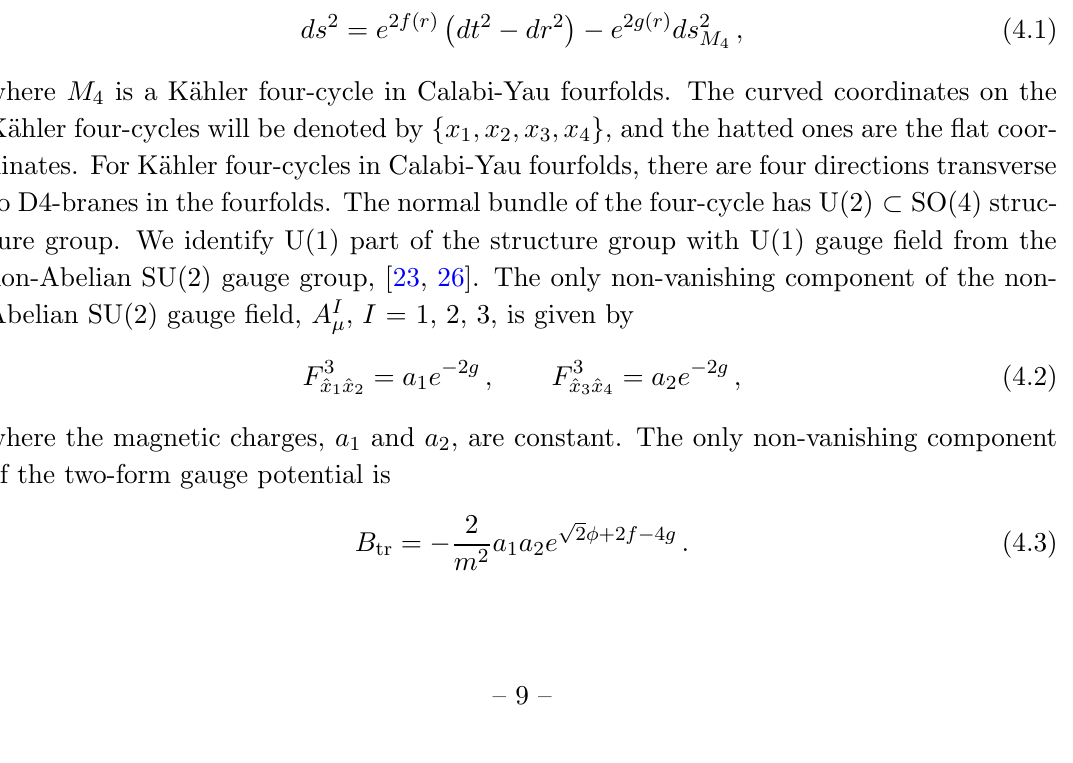
Figure 1 . Numerical black hole solution with m = the values at the AdS 2 horizon given in